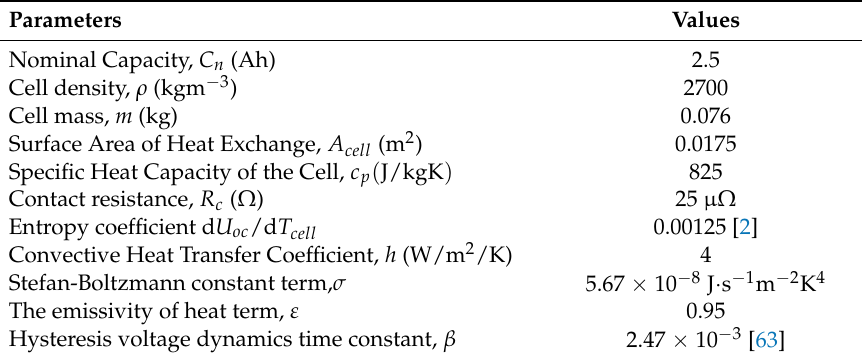
Table 1. Parameters values used in